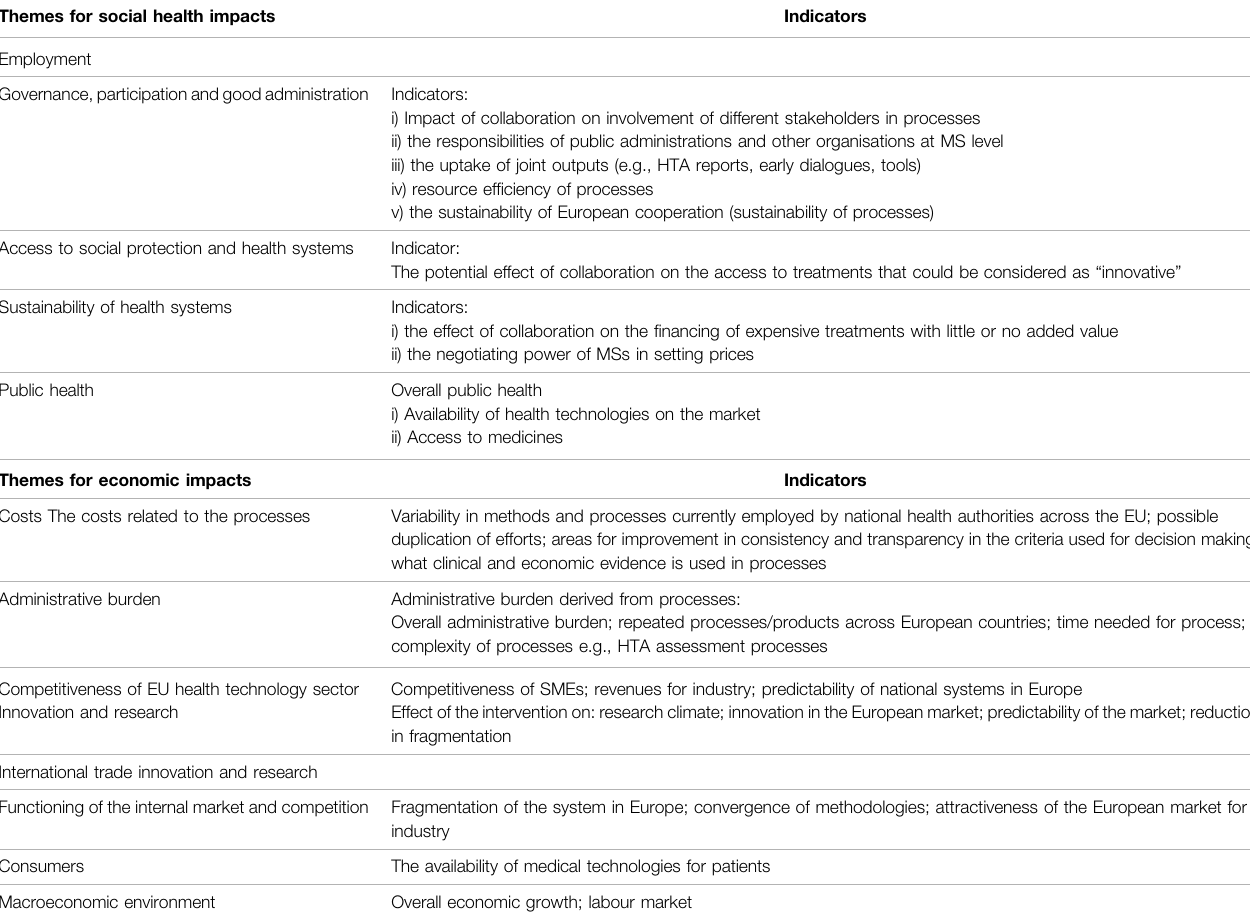
TABLE 1 | Themes and relevant indicators for social health impacts and economic impacts for Member State collaboration. Themes for social health